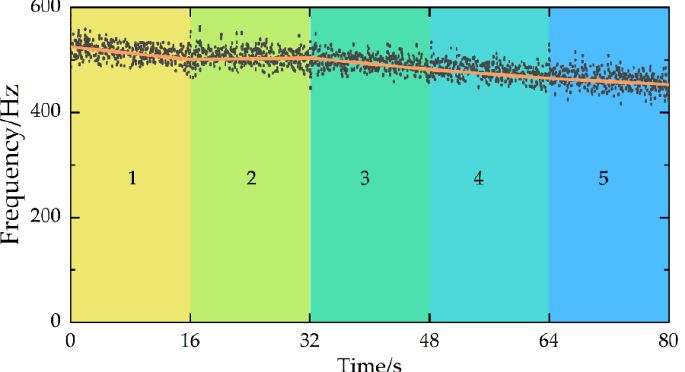
19 of 23 Figure 13. Workpiece displacement responses in different milling stages. From Figures 11 and 13, the vibration responses obviously fluctuated in the cut-in and cut-out stages, with the reason for this being that the dynamic cutting force was higher and the rigidity of the plate was lower in the cut-in and cut-out stages, respectively. For example, at the beginning and end of the fourth group of experiments, there was a significant change in the displacement signal. Therefore, to avoid anomalous